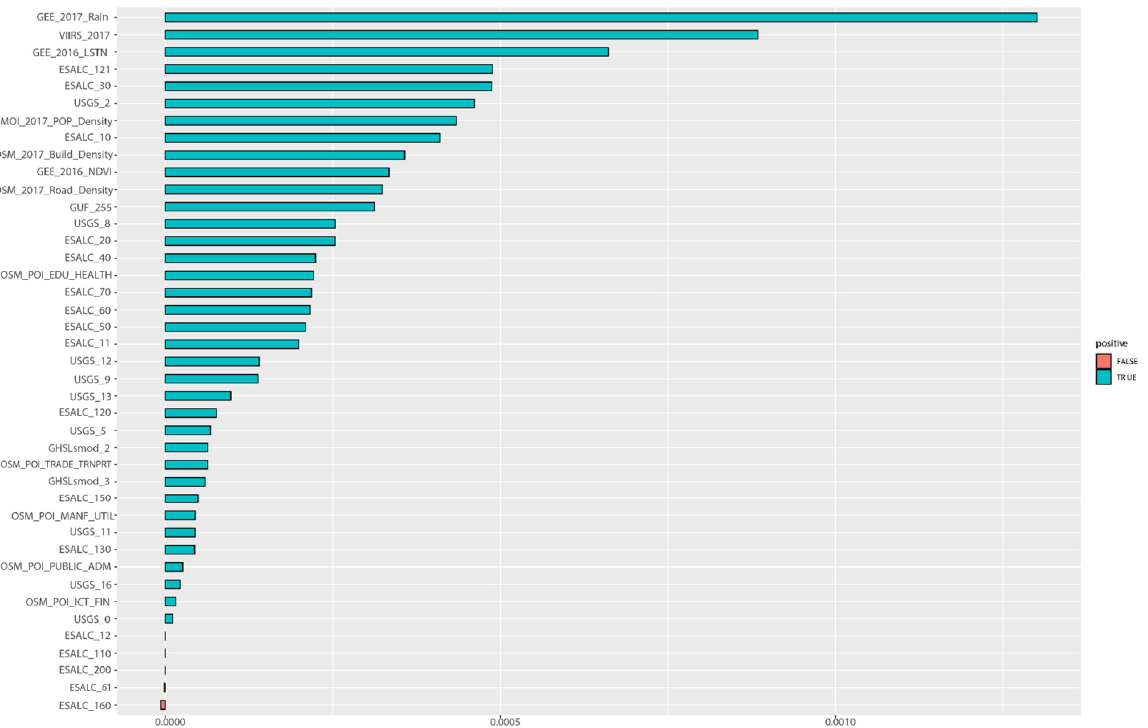
Figure 15. Result of Variable Importance (VIMP) analysis on predicting poverty headcount rates of 2017 (based on RF’s outcome). Source: Calculation and graphics generated by authors.